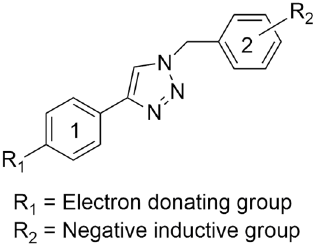
Figure 6. Relationship between structure and antiproliferative activity.